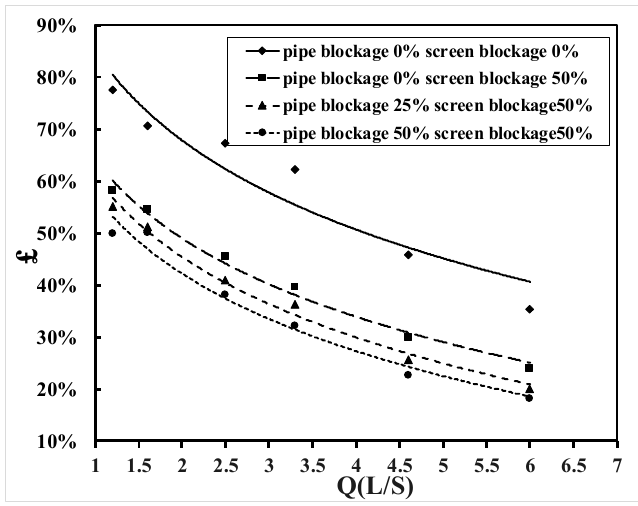
Figure 27. Relationship between £ and Q for di ff erent ratios of blockage height at surface blockage